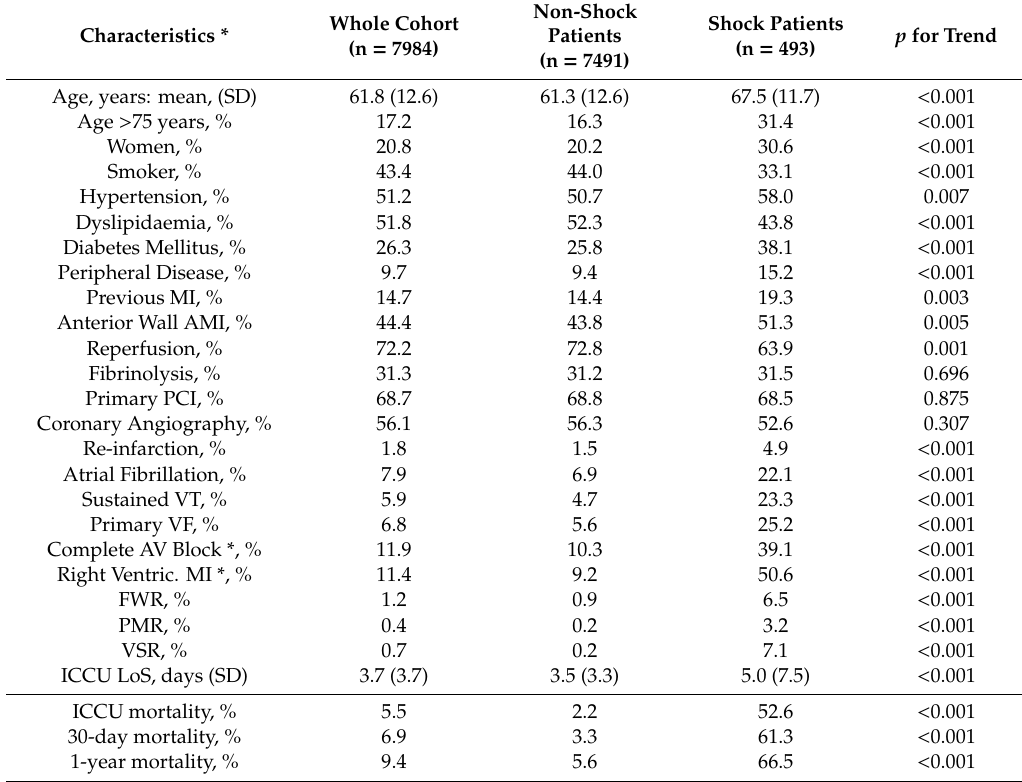
Demographic characteristics, management, and prognosis in shock and non-shock STEMI